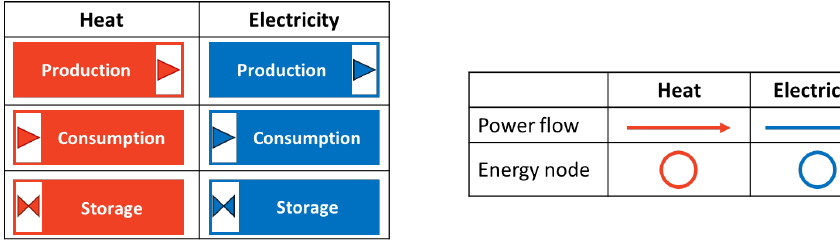
Figure 8. OMEGAlpes formalism for energy system modeling.